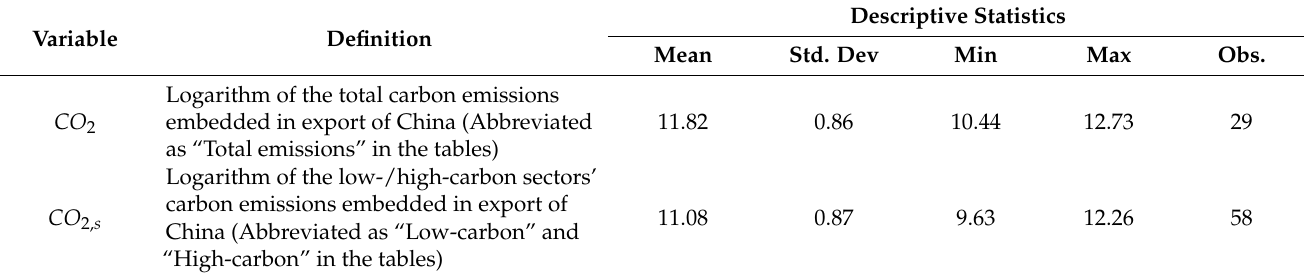
Table 1. Definition and descriptive statistics of the main